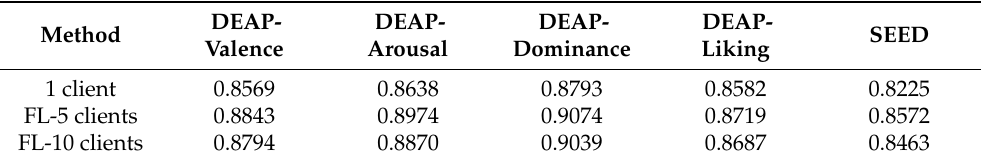
Table 2. Accuracy performance of different training methods on the four emotions of DEAP dataset and SEED